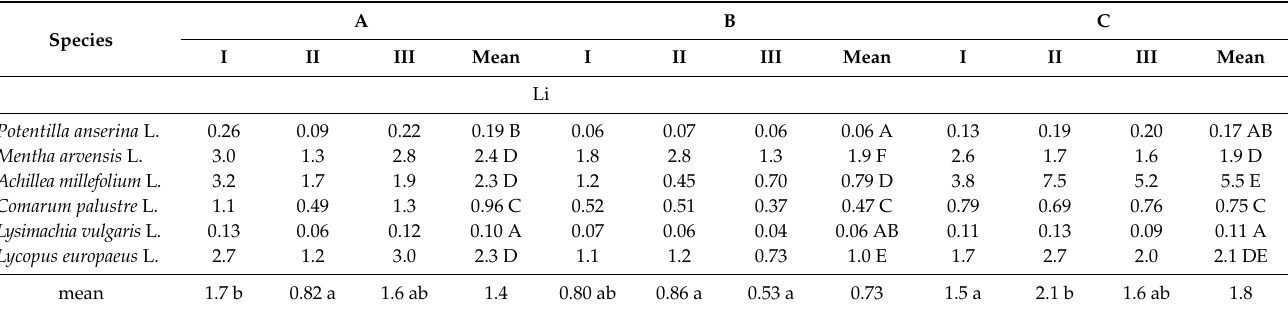
Table 7. Li accumulation coefficient in the